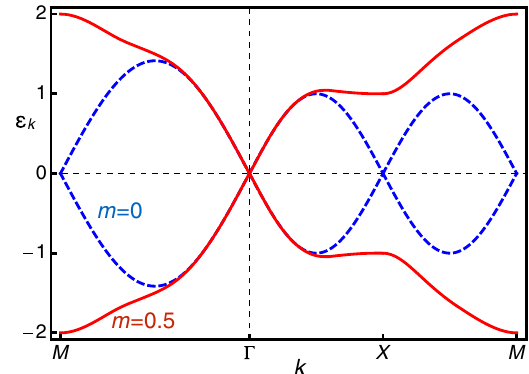
FIG. 3. Band structure (4.2) of the lattice model Eq. (4.1) for λ ¼ 1 and m ¼ 0 (blue dashed) and m ¼ 0 . 5 (red solid line). X and M denote the ð 0 ; π Þ and ð π ; π Þ points of the Brillouin zone,